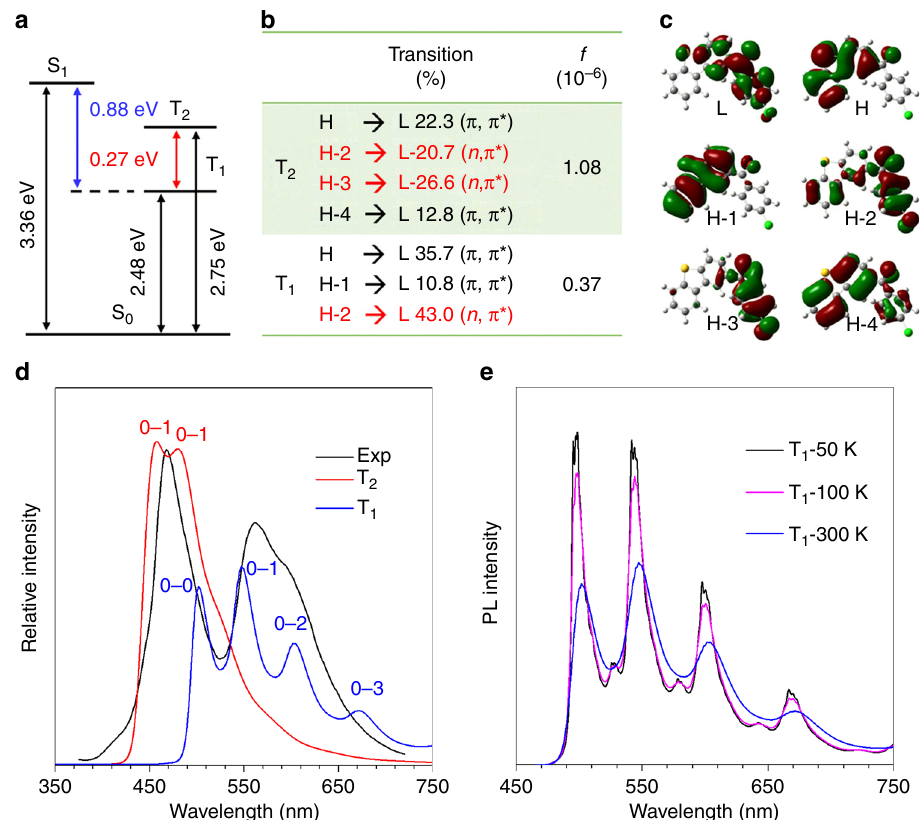
Fig. 4 Theoretical calculations for mechanistic investigation. Calculated a adiabatic energy levels, b electronic transition characters, and c involved frontier molecular orbitals, and emission spectra of d T 1 and T 2 states at 300 K and e T 1 state at different temperature from 50 to 300 K of ClBDBT at (TD) B3LYP/ 6-31(d)/GAFF level. Experimental spectrum (Exp.) is given for